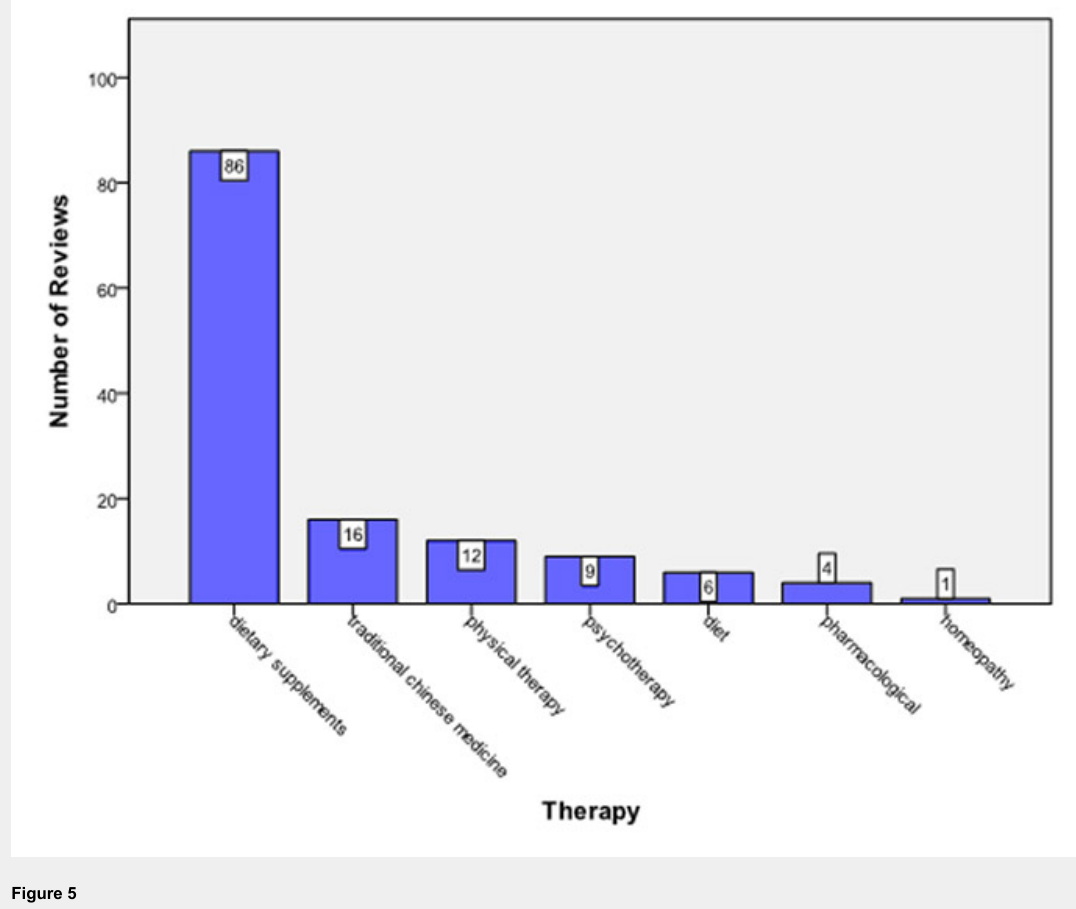
Figure 5 Types of intervention assessed in Cochrane